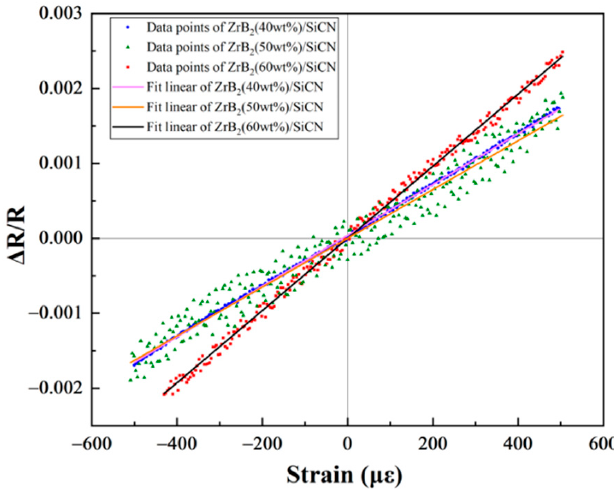
Figure 7. The GFs of the ZrB 2 /SiCN TFSGs.